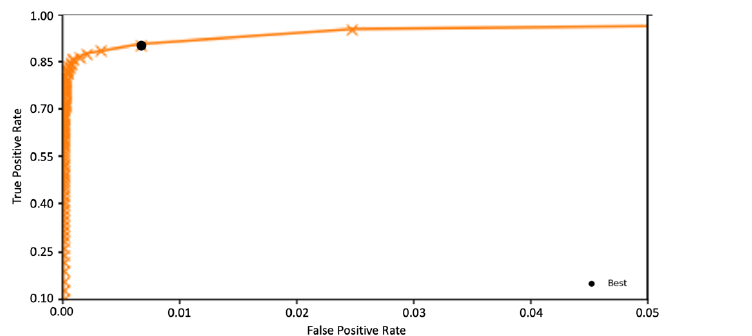
Figure 5. The zoomed-in ROC curve of AE-PRF (for FPR in [0.00, 0.05] and TPR in [0.01, 1.00]).